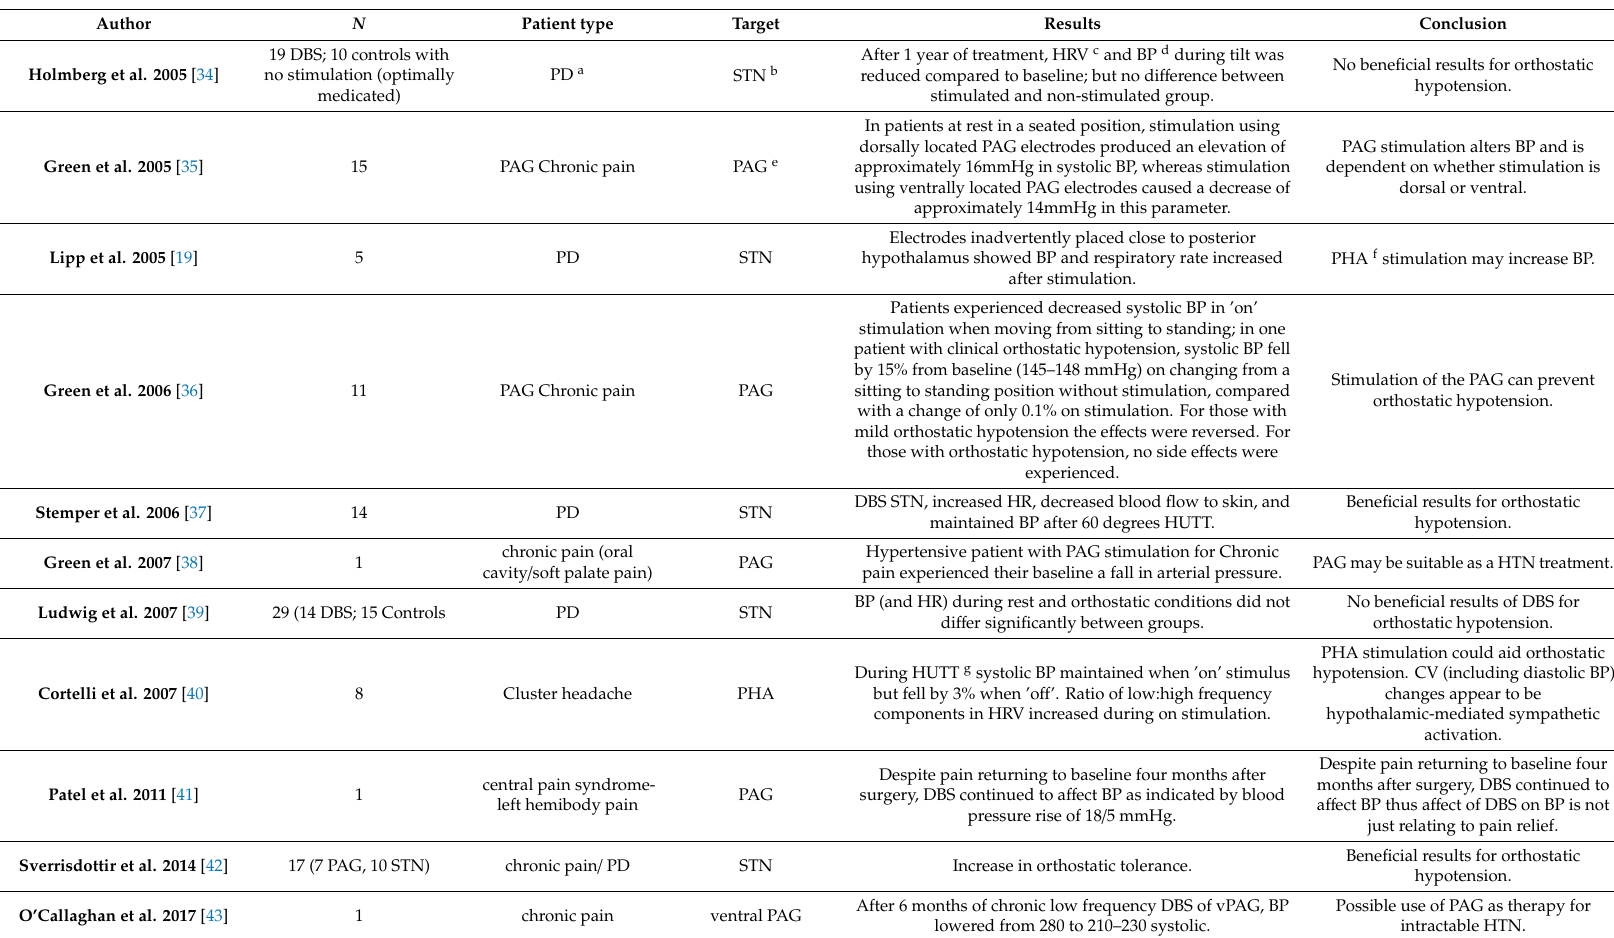
Table 1. Key studies involving DBS and Blood